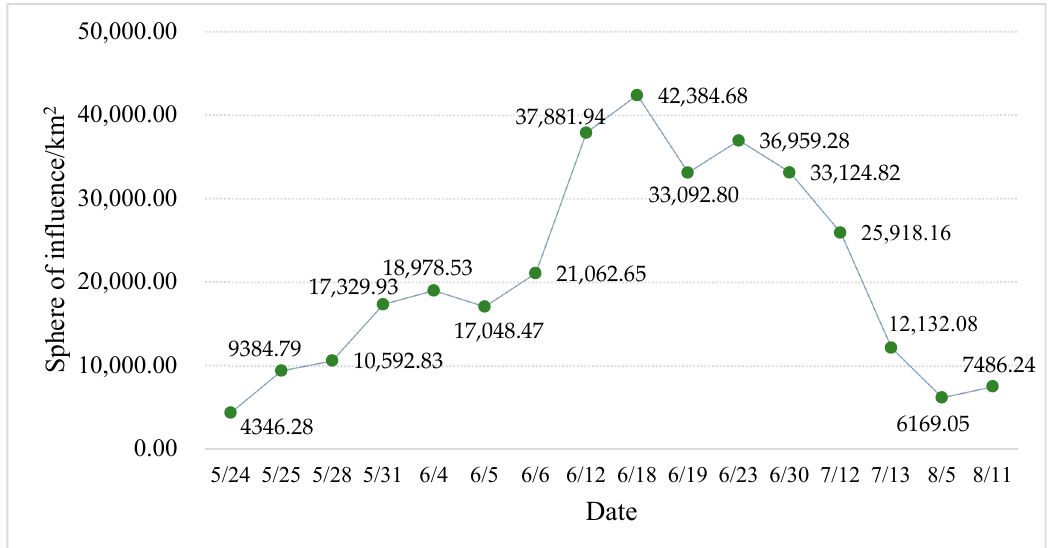
Figure 15. Changes in the influence range of Ulva prolifera over